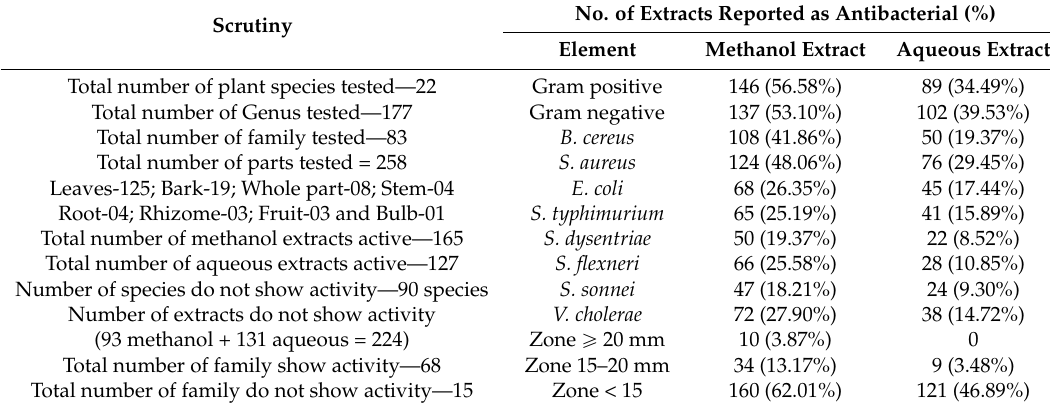
Table 1. Summary of antibacterial activity among the test plants.